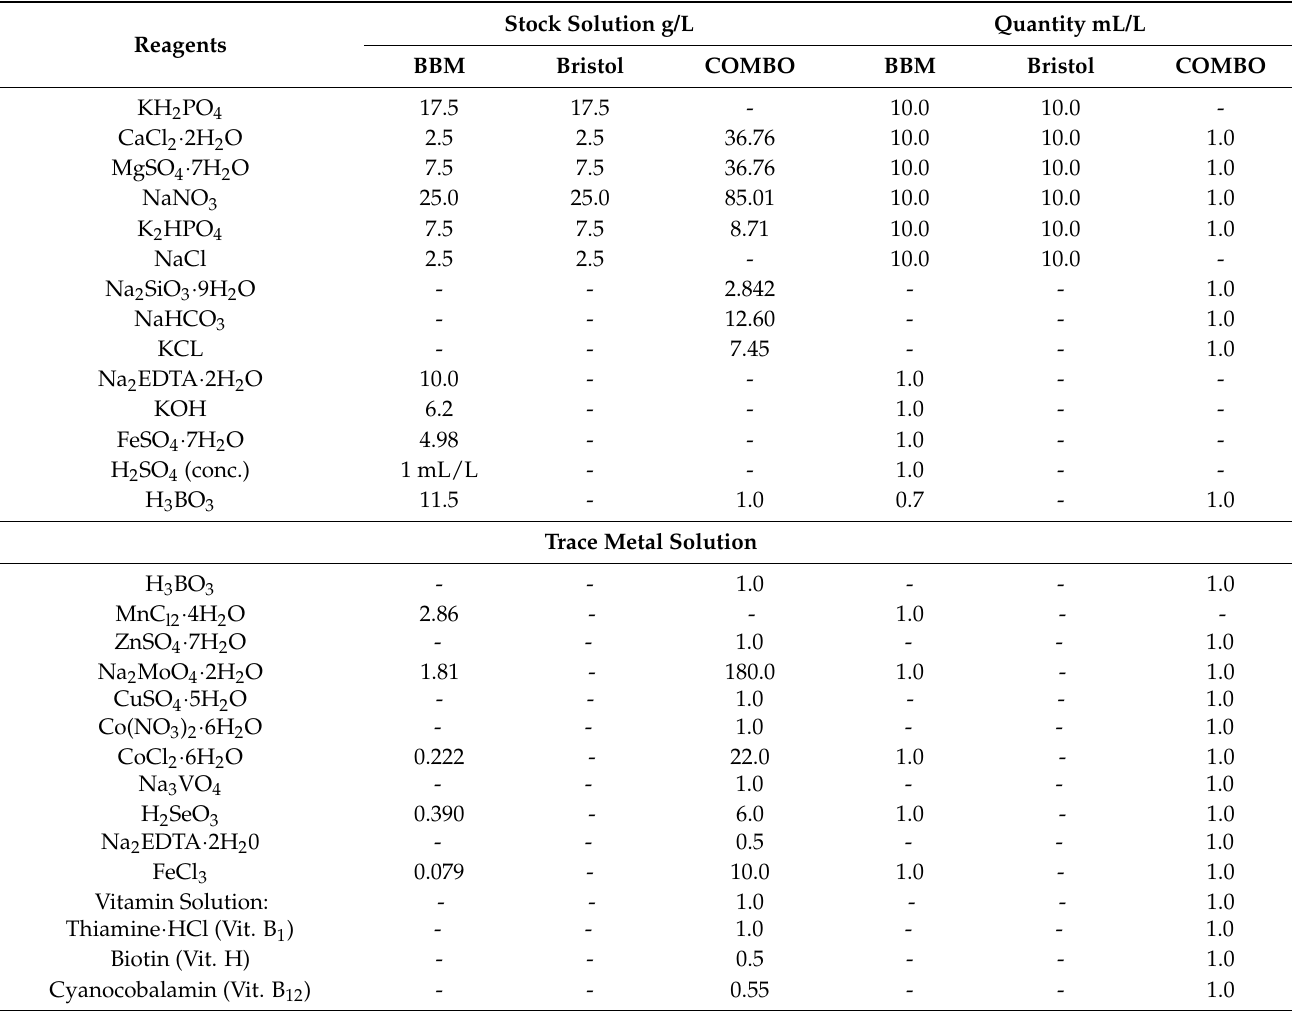
Figure 1. Pure culture of Ankistrodesmus falcatus viewed under a scanning electron microscope. Table 1. Media preparation of Bold’s Basal Medium (BBM) [32], Bristol [33], and Modified COMBO Medium (COMBO) [34].